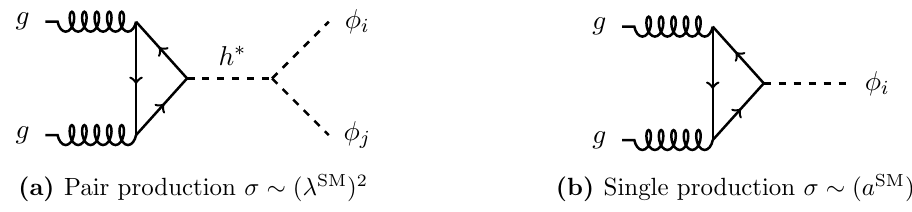
Figure 5. Diagrams for scalar production in the model of eqs. (3.1) and (3.2).